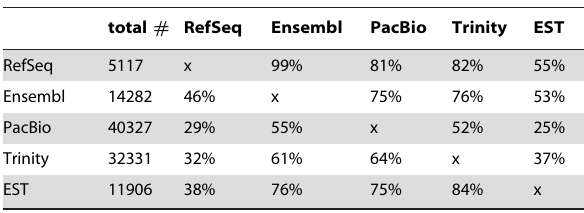
Each cell along a row represents the percentage of elements (whose number is listed in the first column) that is overlapped (by any amount) of an element from the set of data represented in the column header. For example, 99% of RefSeq annotations were overlapped by Ensembl annotations.